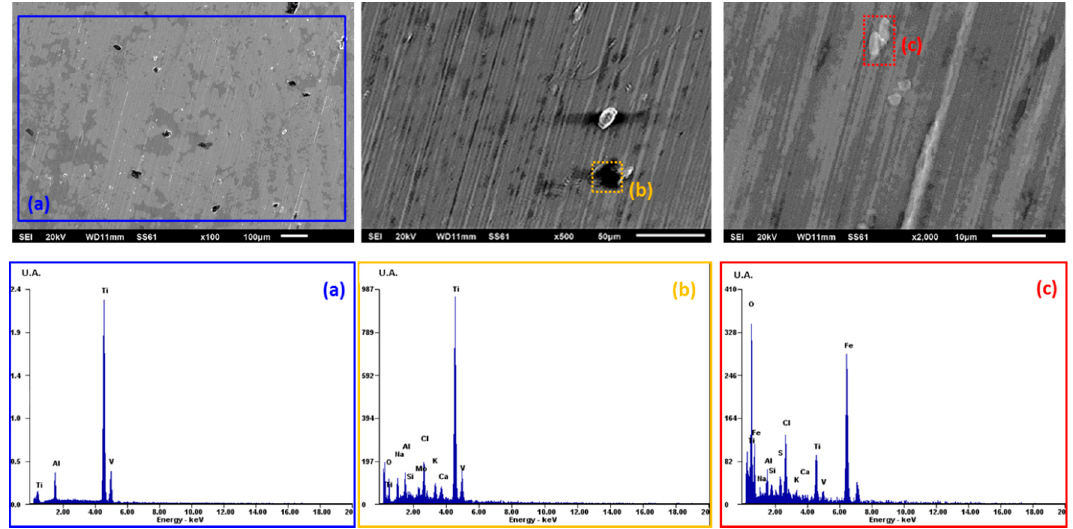
Figure 6. SEM surface morphology micrographs and EDS spectrum of Ti6Al4V in Ringer´s lactate: ( a ) 100X, ( b ) 500X, and ( c ) 2000X.